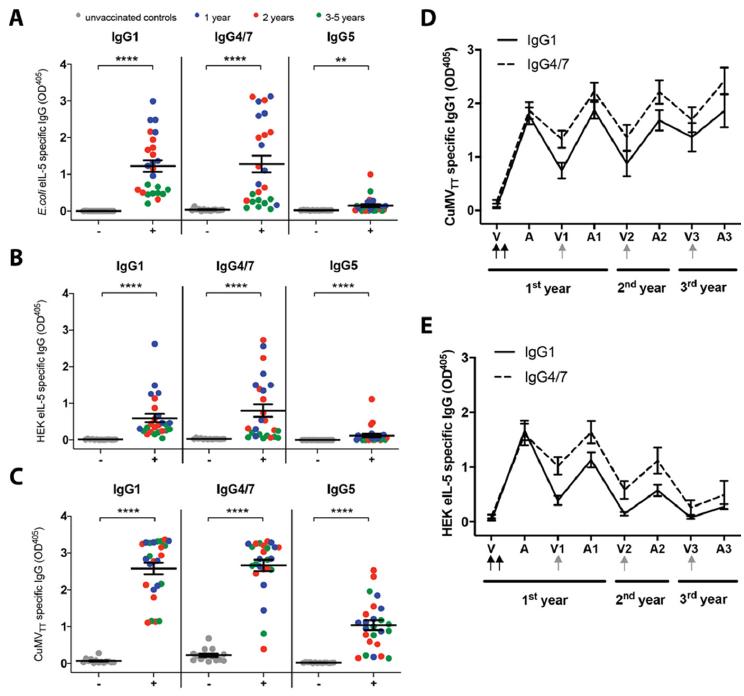
Figure 3. Specific IgG subclasses levels in plasma at the time of the T cell assays. ( A , B , C ) Subclasses in plasma at the same time as the T cell assays. E. coli -eIL-5- ( A ), HEK-eIL-5- ( B ), and CuMV TT - specific ( C ) IgG1, IgG4 / 7, and IgG5 were measured in the plasma of unvaccinated ( − ) control horses (grey), first (blue), second (red), or third (green) year vaccinated ( + ) horses by ELISA. OD405 value of the individual horses with the mean and SEM for each group. The Mann–Whitney U test was used to compare the di ff erence between the groups within each subclass. ( D , E ) IgG1 and IgG4 / 7 were measured in the serum of vaccinated horses against CuMV TT ( D ) and HEK-eIL-5 ( E ) by ELISA, mean with SEM. The time points measured: before the initial vaccinations (V), after the initial vaccinations ( A ), at the time of the annual boost at the 1st year (V1), 2–4 weeks after the boost at the 1st year (A1), at the time of the annual boost at the 2nd year (V2), 2–4 weeks after the boost at the 2nd year (A2), at the time of the annual boost at the 3rd year (V3), and 2–4 weeks after the boost at the 3rd year (A3). Black arrows indicate the initial vaccinations and the gray arrows the yearly booster. ** p < 0.01; **** p < 0.0001.